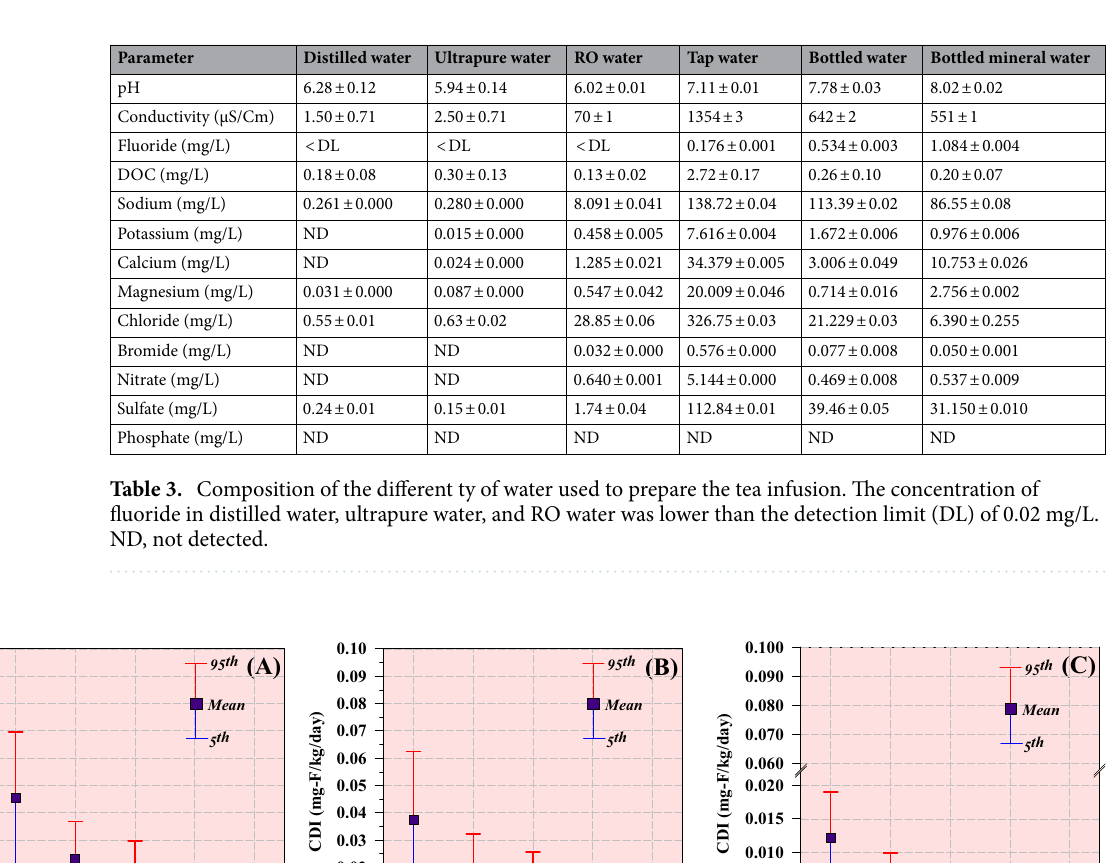
Figure 3. Effect of types of brewing water on fluoride infusion using crushed black tea with a brewing time of 5 min.